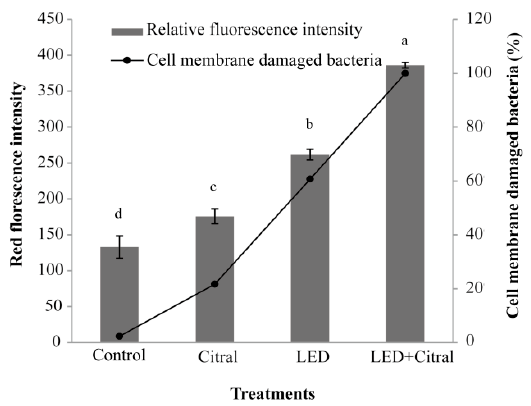
Figure 3. Effect of 405 nm LED illumination and 0.1 mg/mL of citral on outer membrane integrity of Vibrio parahaemolyticus for 30 min. Means marked with different lower-case letters are statistically different ( p < 0.05).